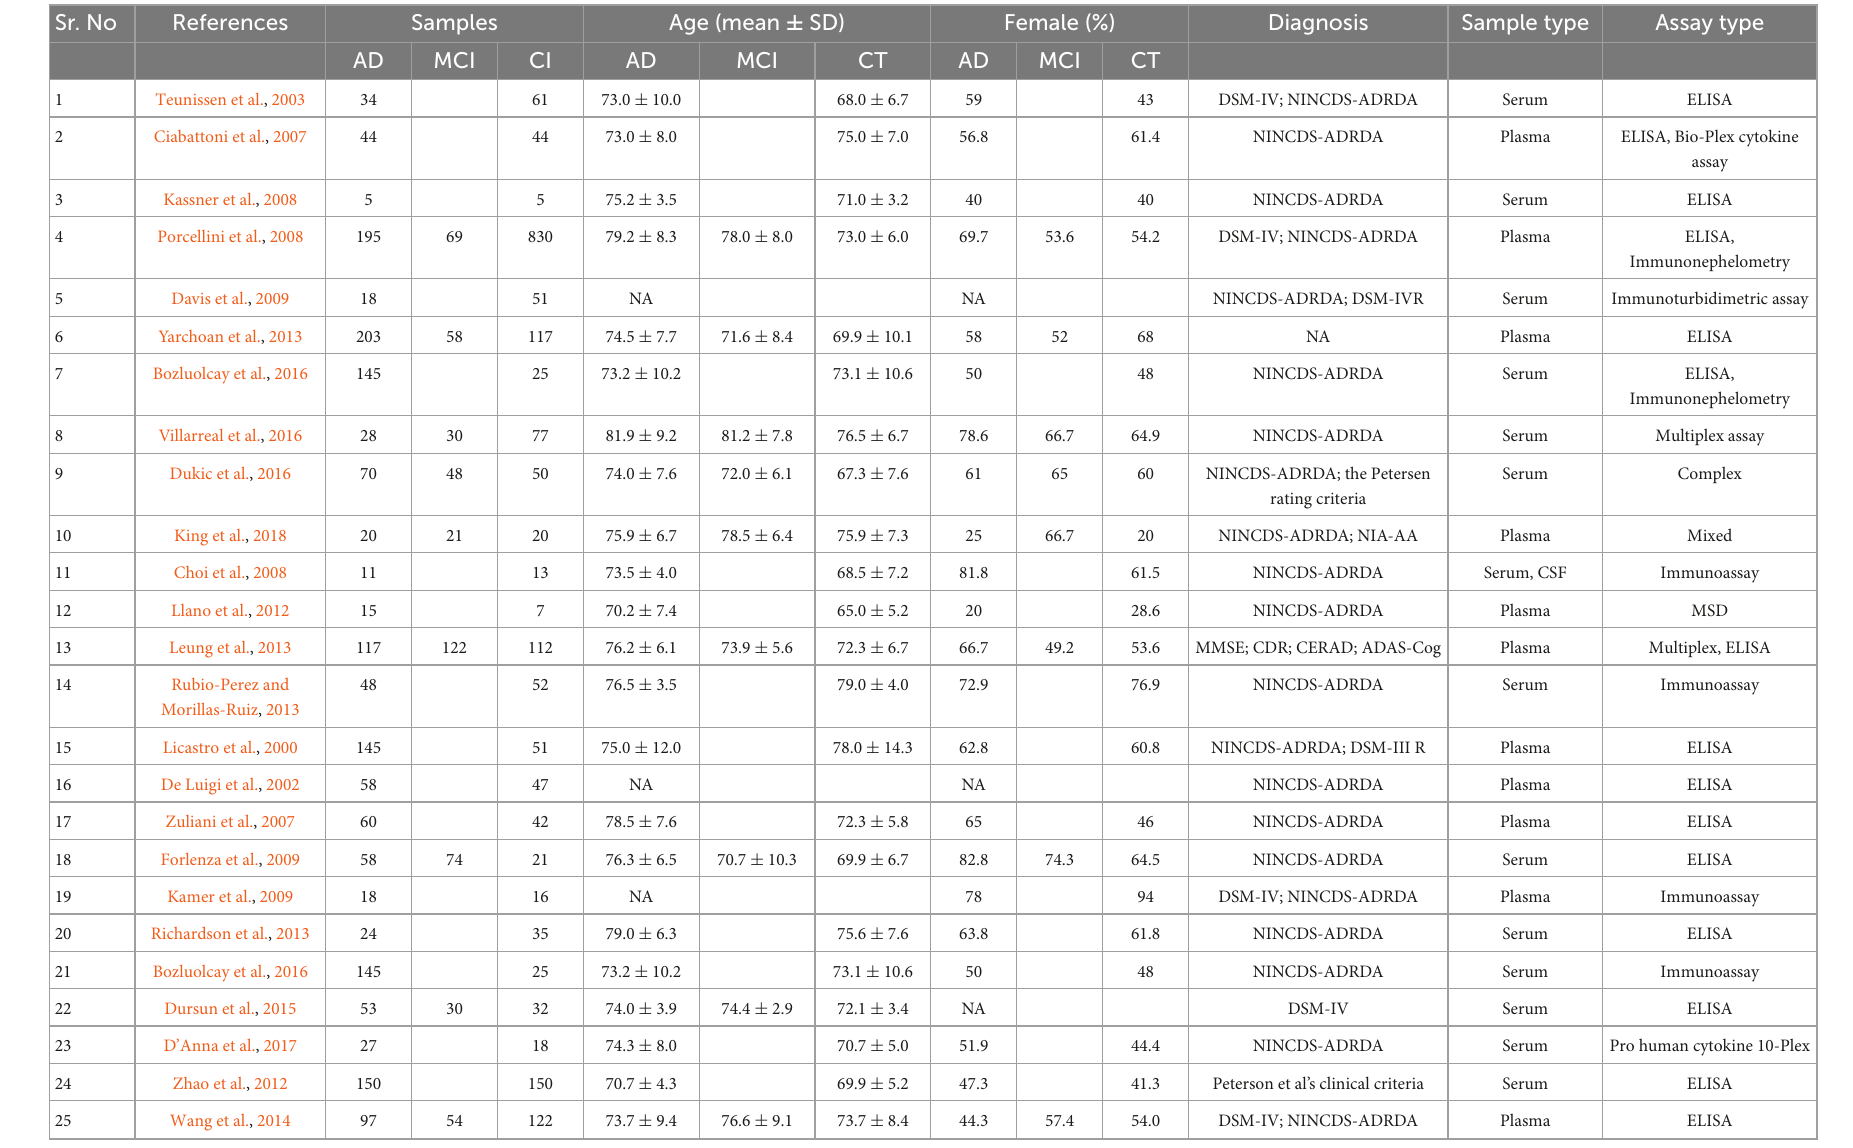
TABLE 1 Characteristics of included patients and cross-sectional